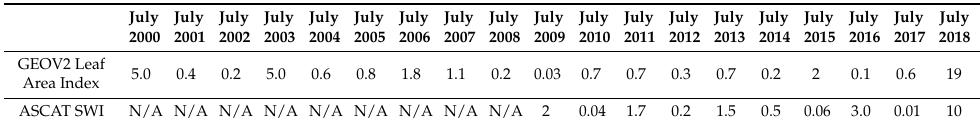
Figure 2. Monthly anomalies (scaled by standard deviation, expressed in units of standard deviation) maps for July 2018 for ( a ) GEOV2 Leaf Area Index with respect to 2000–2018 and ( b ) Surface Soil Moisture with respect to 2008–2018 from the Copernicus Global Land Service. Green/red colors represent positive/negative anomalies in units of standard deviation. Table 2. Percentage of the domain with monthly anomalies lower than -2 stdv for satellite derived GEOV2 Leaf Area Index, ASCAT surface soil moisture. Only months of July are